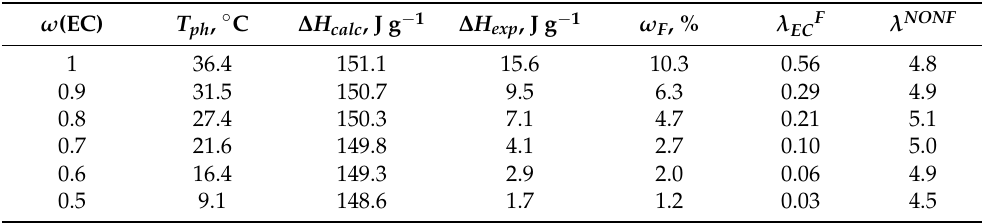
Table 1. Calculated phase transition temperatures ( T ph ) and experimental values of the fusion enthalpy ( ∆ H *), fraction of freezing EC ( ω F ), number of freezing EC ( λ ECF ), and nonfreezing solvent ( λ NONF ) molecules in the sodium form of Nafion membrane swollen at 40 ◦ C.